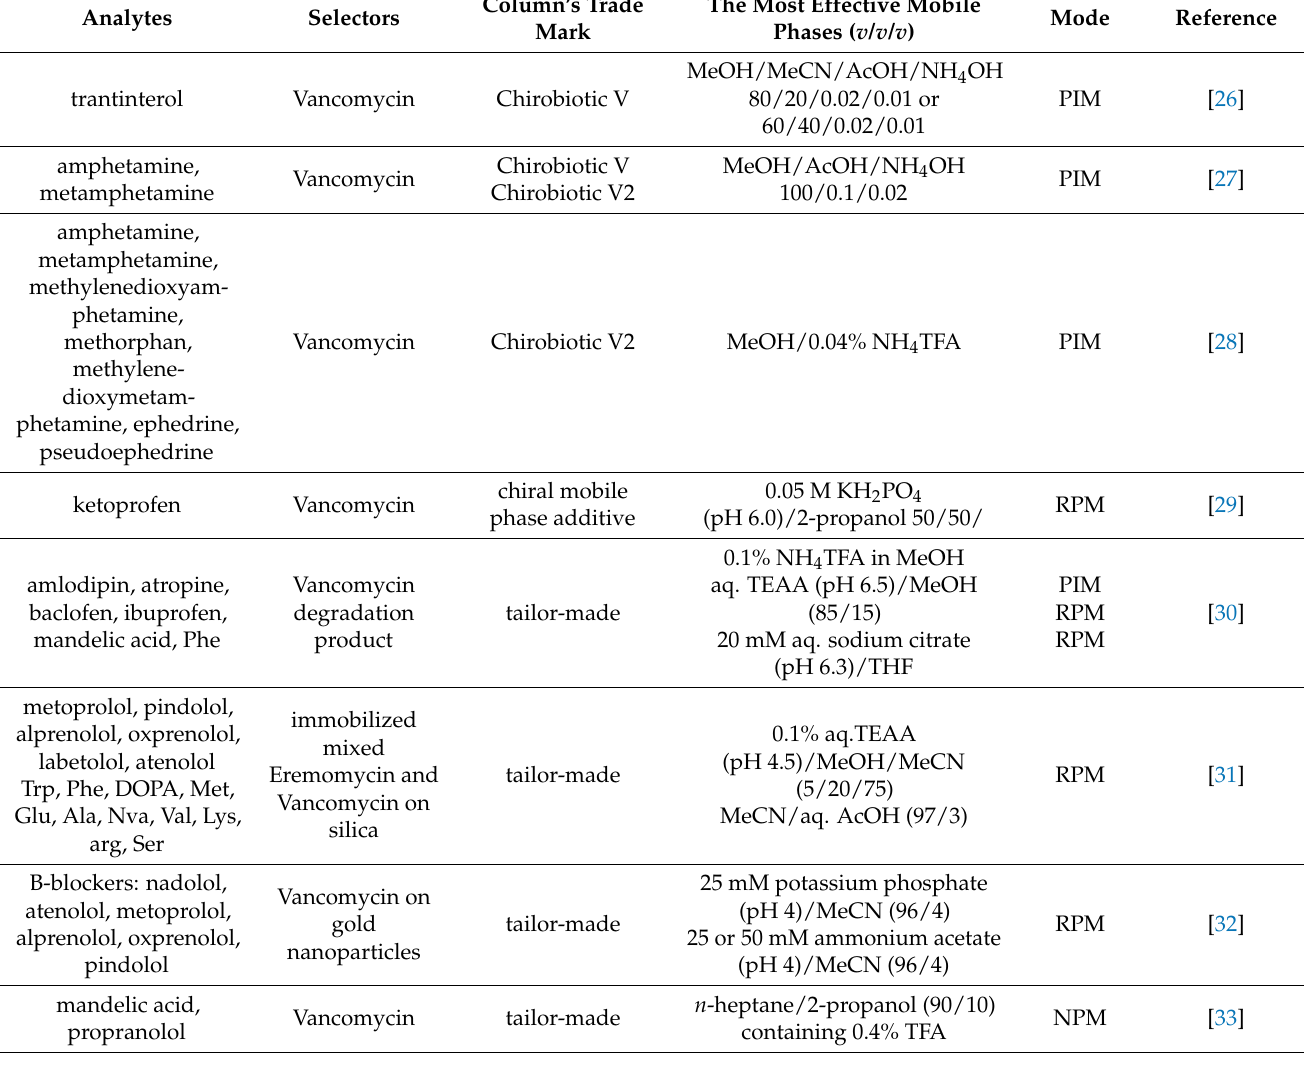
Table 3. Enantioseparation of stereoisomers of different analytes on vancomycin- and vancomycin-related analog-based CSPs 1 .